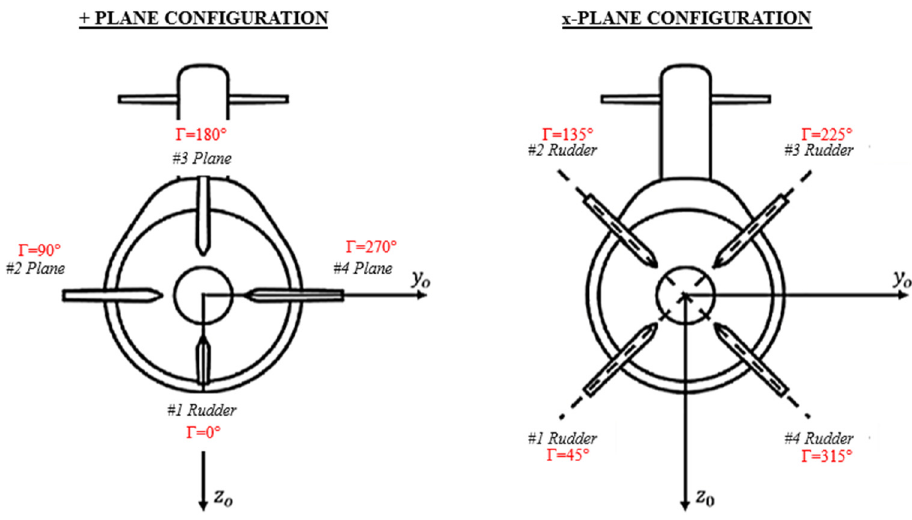
Figure 4. Stern control surfaces—configurations.